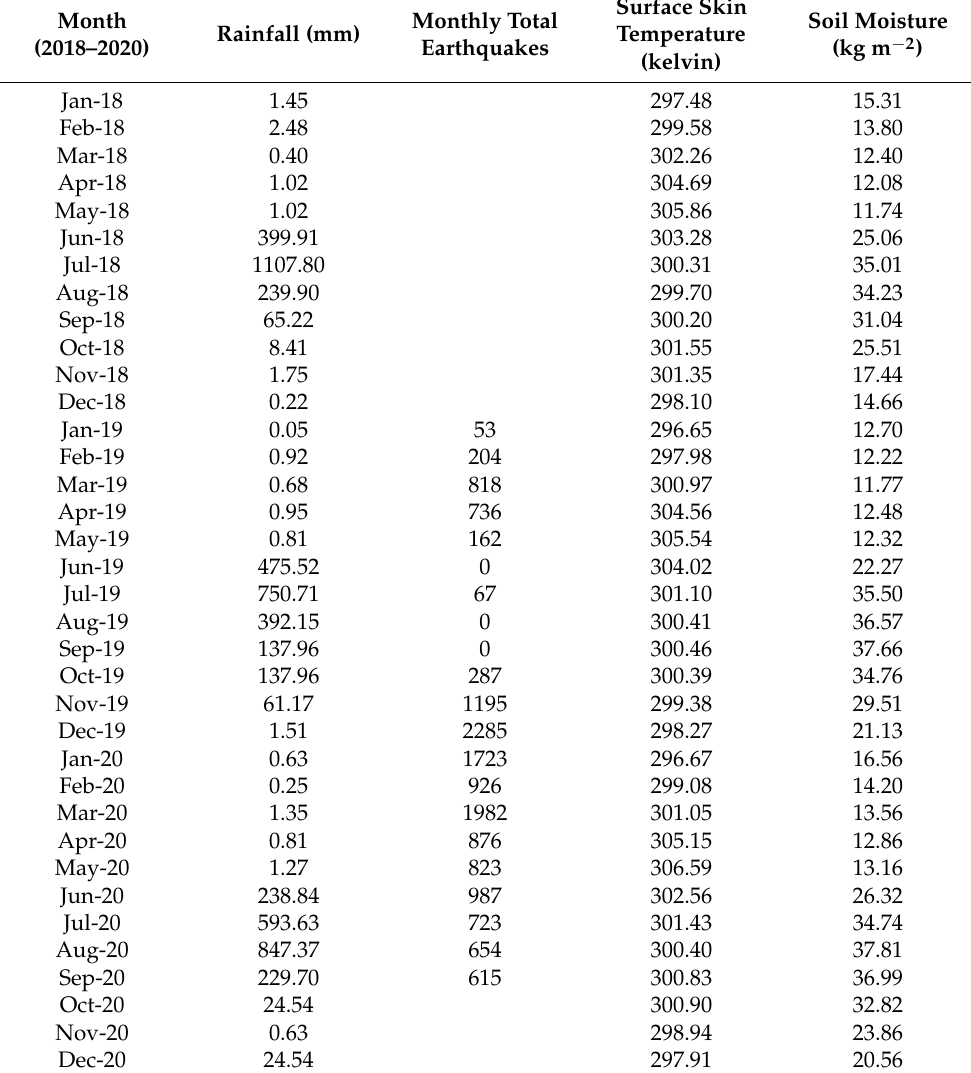
Table A2. Monthly Total Atmospheric and Geophysical Parameters data and Monthly Total